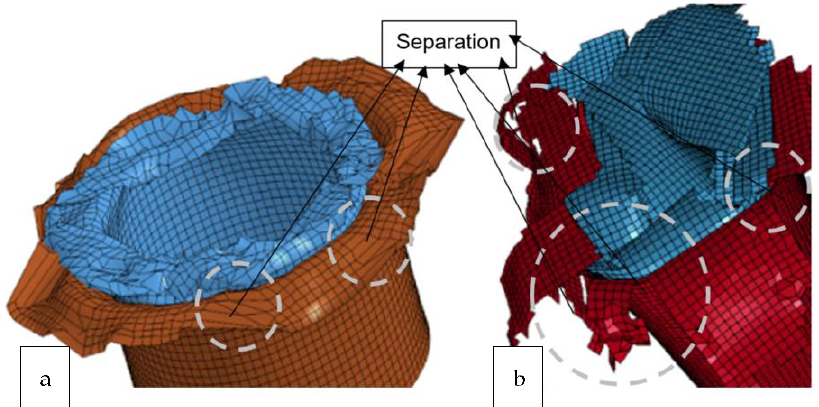
Figure 23. Effect of DFAILM on axial split, ( a ) reference model ( b ) 10% increase DFAILM [65].